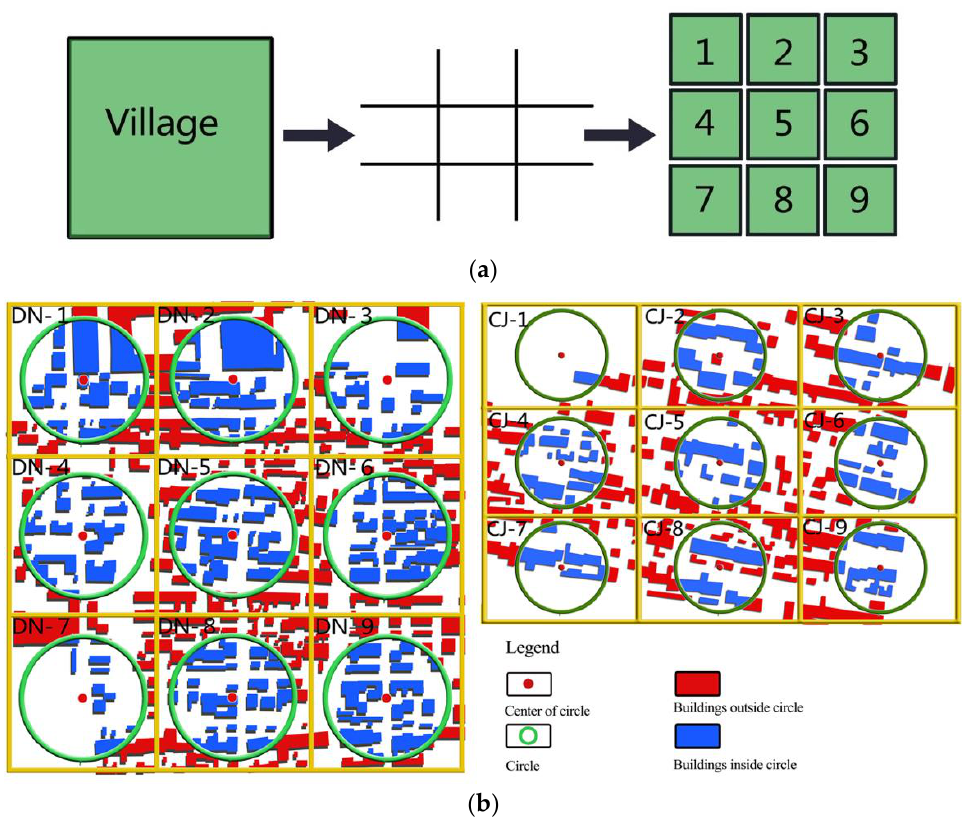
Figure 2. CJ village and DN village were divided into nine equal zones with the method of three- by-three grids: ( a ) method; ( b ) schematic diagram of the calculation method of